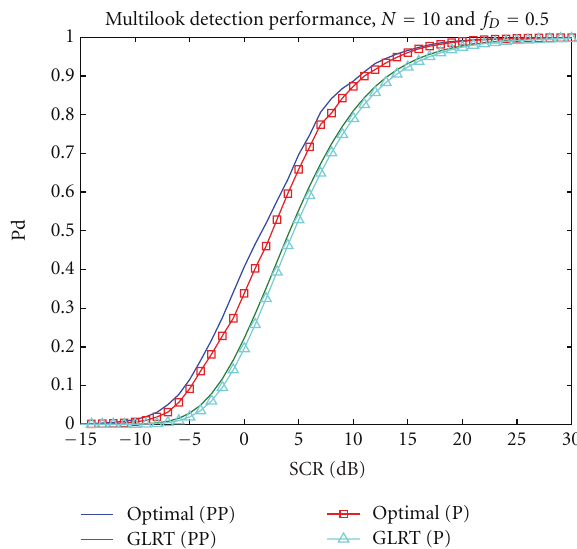
Figure 4: Comparison of detector performance curves for Pareto and Pareto mixture models. The probability of detection (Pd) is plotted as a function of the signal to clutter ratio (SCR). The optimal detectors are denoted Optimal (PP) for the mixture model and Optimal (P) for the standard Pareto counterpart. The GLRT for the Pareto mixture is denoted GLRT (PP), while the same for a single Pareto model is GLRT (P). The figure shows that the mixture model provides only a very small detection